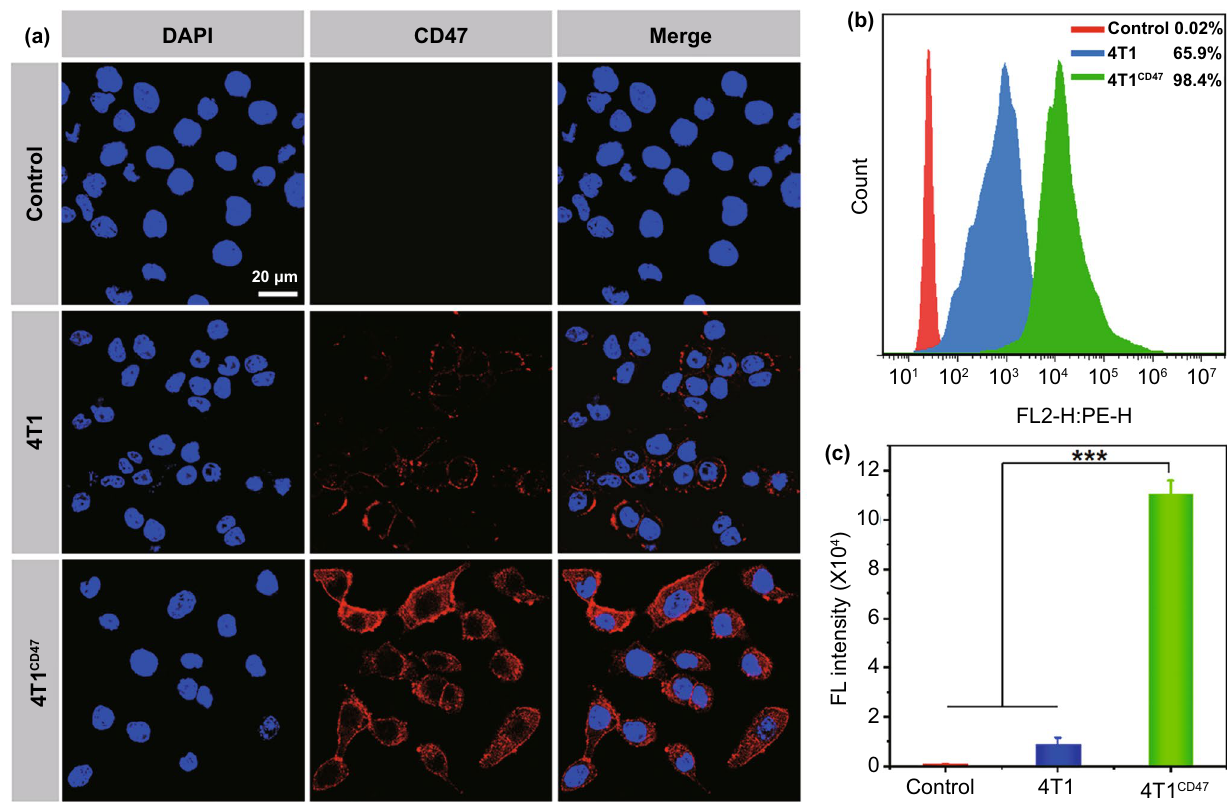
Fig. 1 a CLSM images and b flow histogram of the level of CD47 expression. c Quantitative analysis of the CD47 expression. ( ***p < 0.001, n =